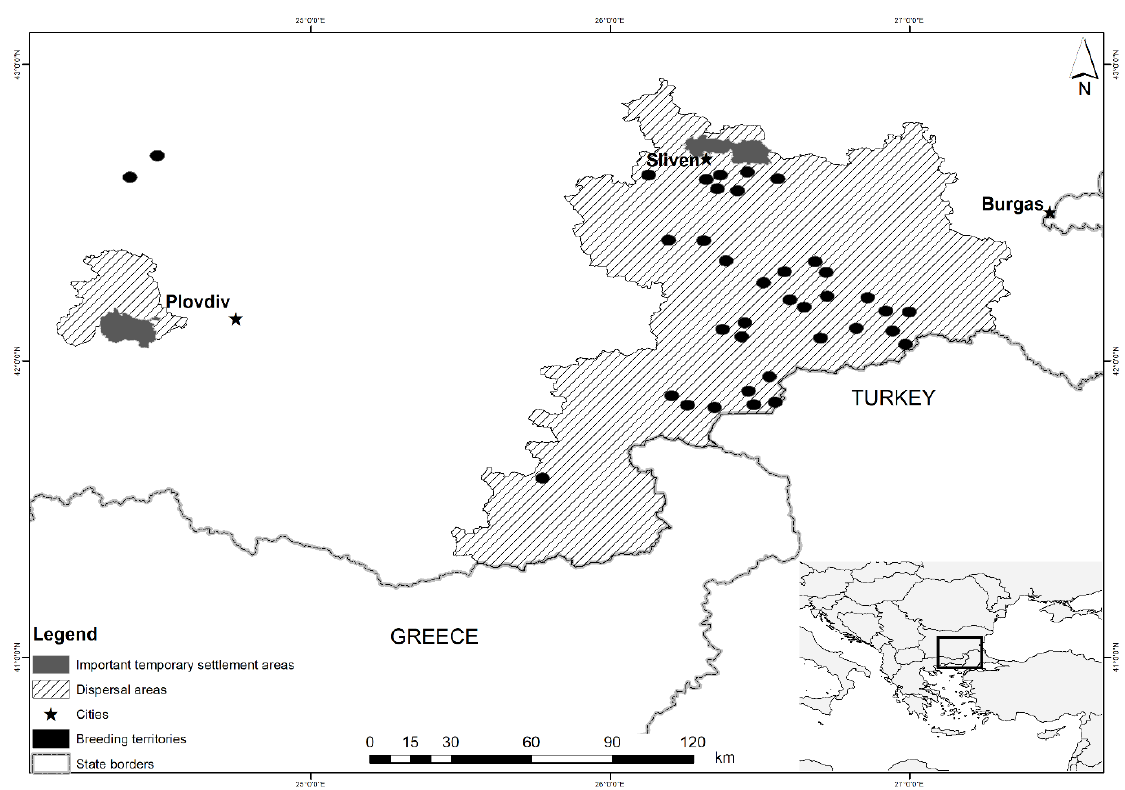
Figure 1. Dispersal areas (shaded) and breeding territories (black dots) used by the Eastern Imperial Eagle ( Aquila heliaca ). Two important temporary settlement areas (Besaparski hills and Sliven field) are given in grey.